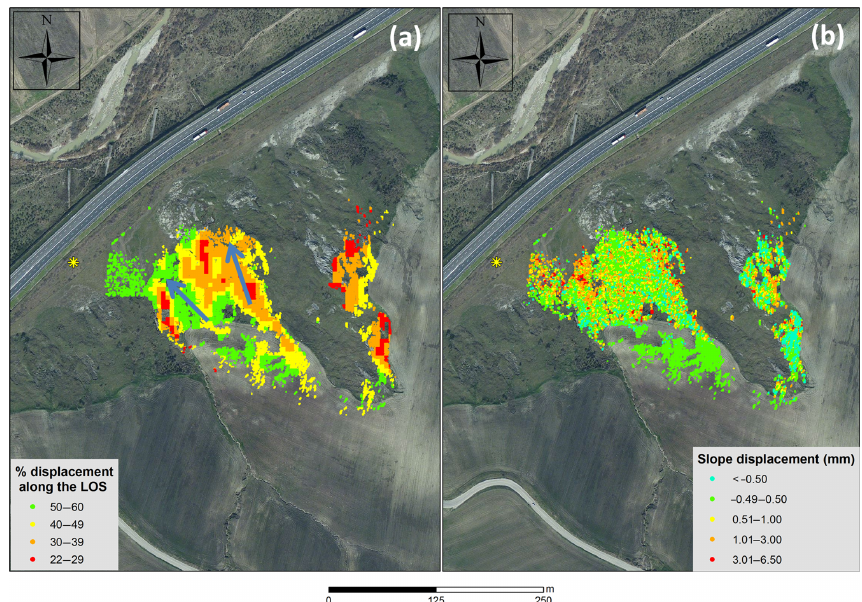
Figure 5. (a) C values map. Blue arrows indicate the downslope direction. (b) Cumulated displacement values projected in the downslope direction, referring to a period between 1 July and 1 November 2014. The yellow asterisk on the left of the images represents the location of the